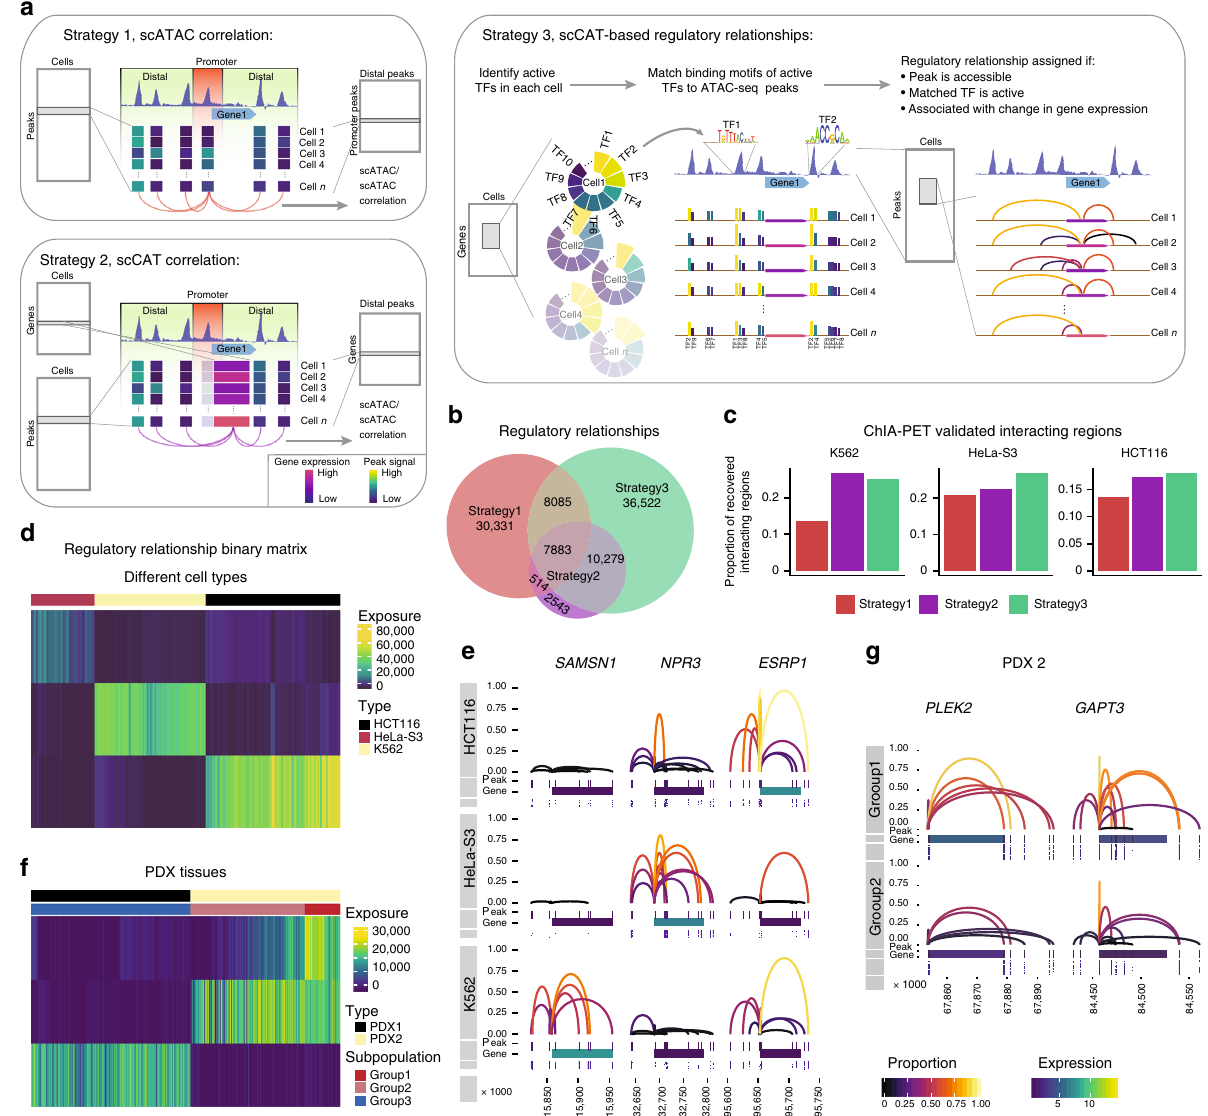
Fig. 2 Inferring regulatory relationships between CREs and genes by scCAT-seq. a Overview of three strategies for inferring regulatory relationships. Strategy 1: regulatory links for every gene were assigned when the Spearman correlation of the signal of peaks located at the promoter and distal peaks was above 0.25. Strategy 2: the regulatory links were assigned if the Spearman correlation between the gene expression and the signal of distal peaks was above 0.25. Strategy 3: active transcription factors for every cell were identi fi ed by SCENIC, then active regions were identi fi ed by matching the binding motifs of active transcription factors to accessible regions. Then regulatory relationships were assigned after applying a Wilcoxon test to determine if the presence of a nearby active accessible region was associated with a signi fi cant change in the target gene expression ( P -value < 0.05). b Venn plot showing the number of overlapping regulatory relationships identi fi ed by the three strategies. c Proportion of ChIA-PET validated regulatory relationships identi fi ed by the three strategies in K562 (left), HeLa-S3 (middle), and HCT116 (right) single cells. d , f Heatmaps showing exposure scores of all cells to each signature identi fi ed by the NMF clustering of regulatory relationship binary matrices of cell lines ( d ) and PDXs ( f ). The exposure score represents the contributions of the signatures to the different samples. e , g Regulatory relationships for the indicated genes in single-cell groups of the cell lines ( e ) and PDX2 ( g ). Each panel contains three tracks: the top track shows the regulatory relationship between one peak and the gene (linking them with an arch), where the height and color of the arch show the proportion of cells that share the regulatory relationships; the middle track shows the genomic location of the gene and the associated peaks, where the color of the gene shows the mean expression in each cell type; the bottom track shows the accessible states (on and off) for each peak in each single